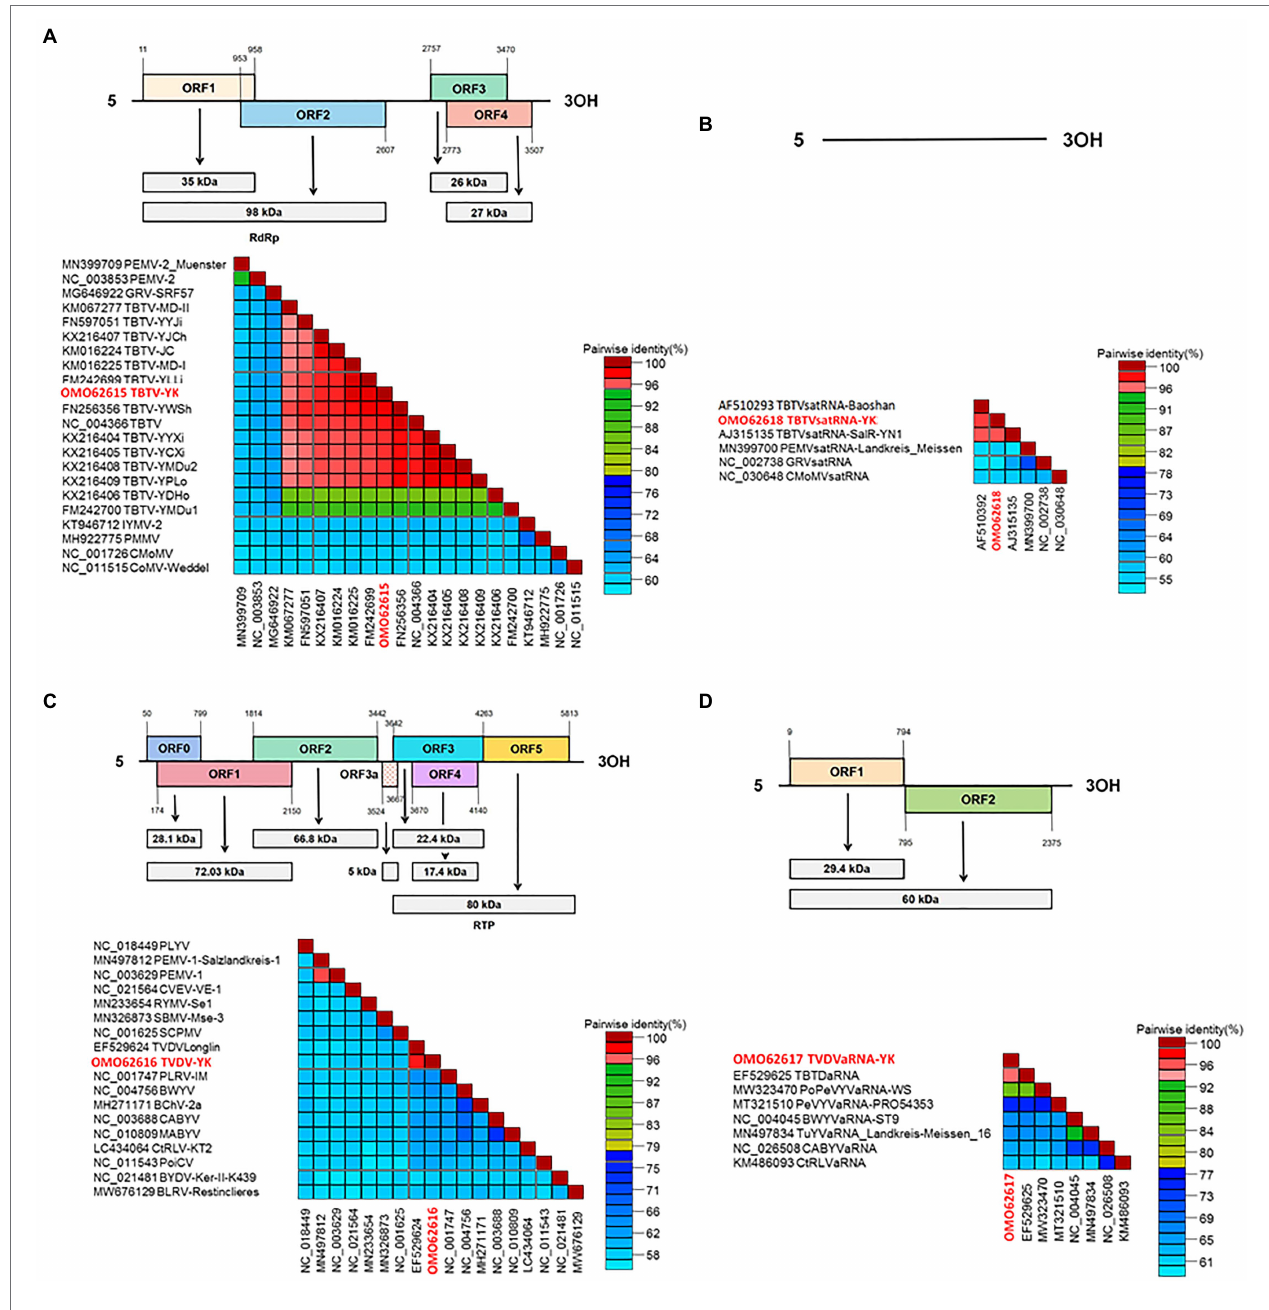
FIGURE 1 | Genome organization of TBTV-YK, TVDV-YK, TBTVsatRNA-YK, and TVDVaRNA-YK, and the pairwise identity matrices of complete nucleotide (nt) sequences generated using the Sequence Demarcation Tool version 1.2. (A) Genome structure of TBTV-YK and the pairwise identity matrix of TBTV-YK and other viruses in the genus Umbravirus , Tombusvirus , and Luteovirus in the family Tombusviridae . (B) Genome structure of TBTVsatRNA-YK and the pairwise identity matrix of TBTVsatRNA-YK and other satellite RNAs associated with the viruses in the genus Umbravirus . (C) Genome structure of TVDV-YK and the pairwise identity matrix of TVDV-YK and other viruses in the genus Polemovirus , Polerovirus , Sobemovirus , and Enamovirus in the family Solemoviridae and the viruses in the family Tombusviridae . (D) Genome structure of TVDVaRNA-YK and the pairwise identity matrix of TVDVaRNA-YK and other Tombusvirus-like associated